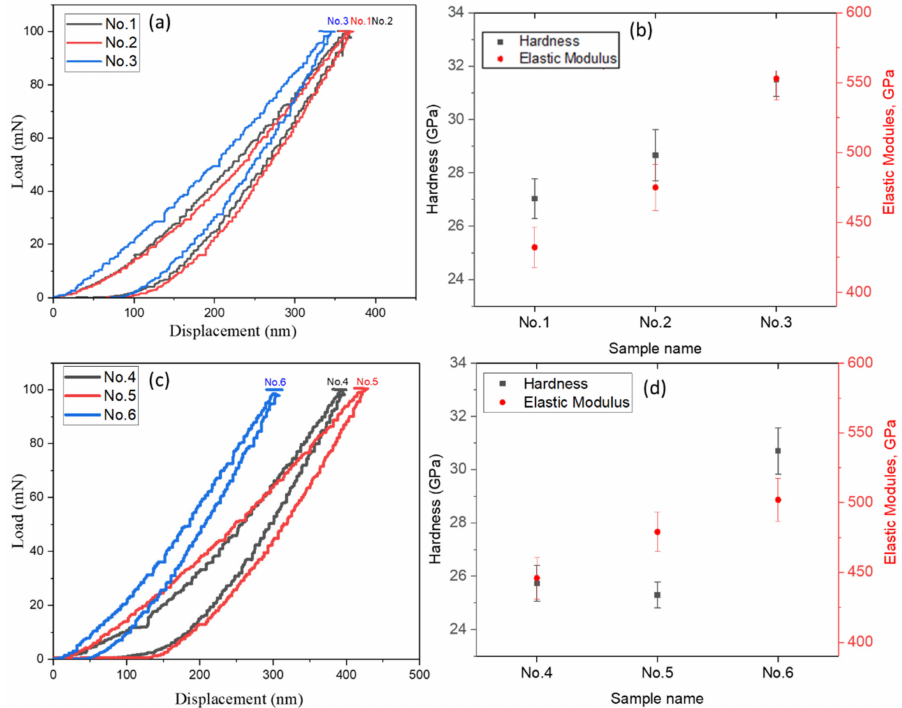
Figure 7. Results of nanoindentation of (TiZrNb)N coatings: ( a – c ) Typical indentation force– penetration curve during nanoindentation test; ( b , d ) The hardness and elastic